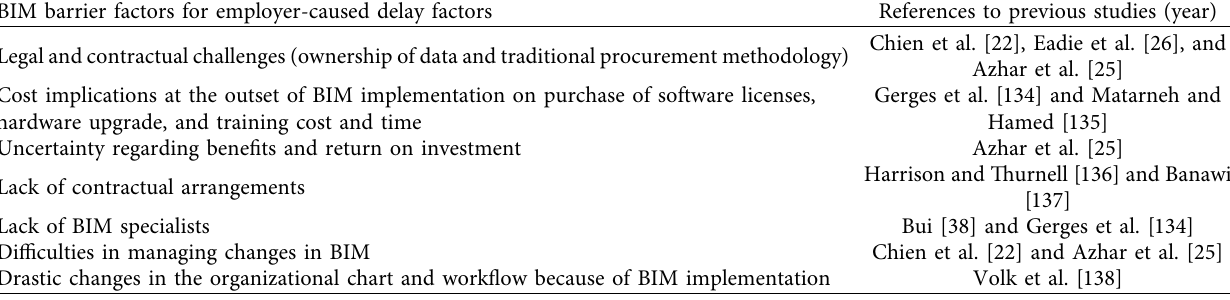
Table 11: BIM barrier factors for employer-caused delay factors.